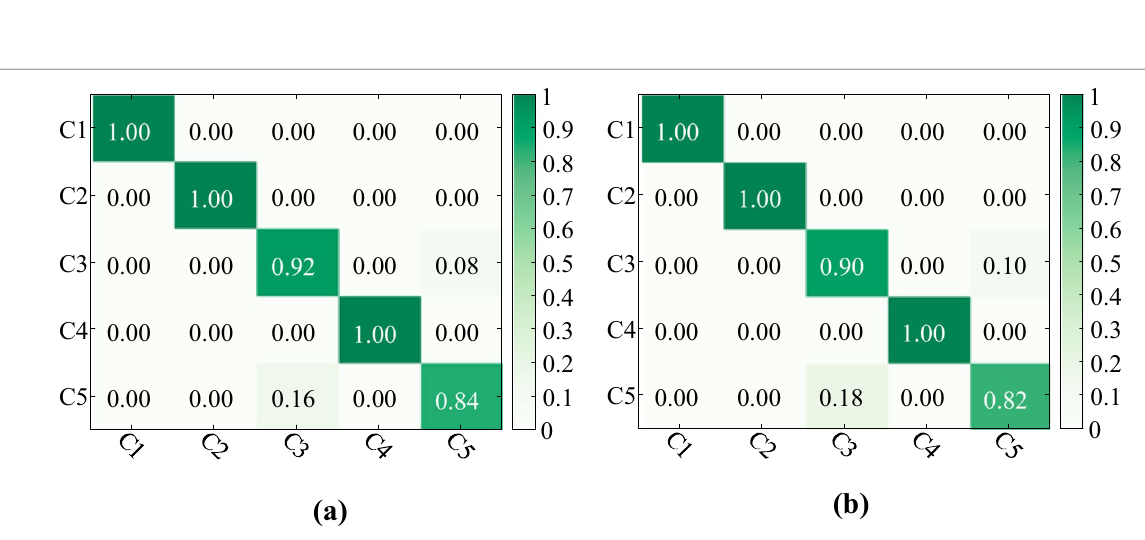
Figure 12 Confusion matrix of NMPT on transferring datasets from adjacent